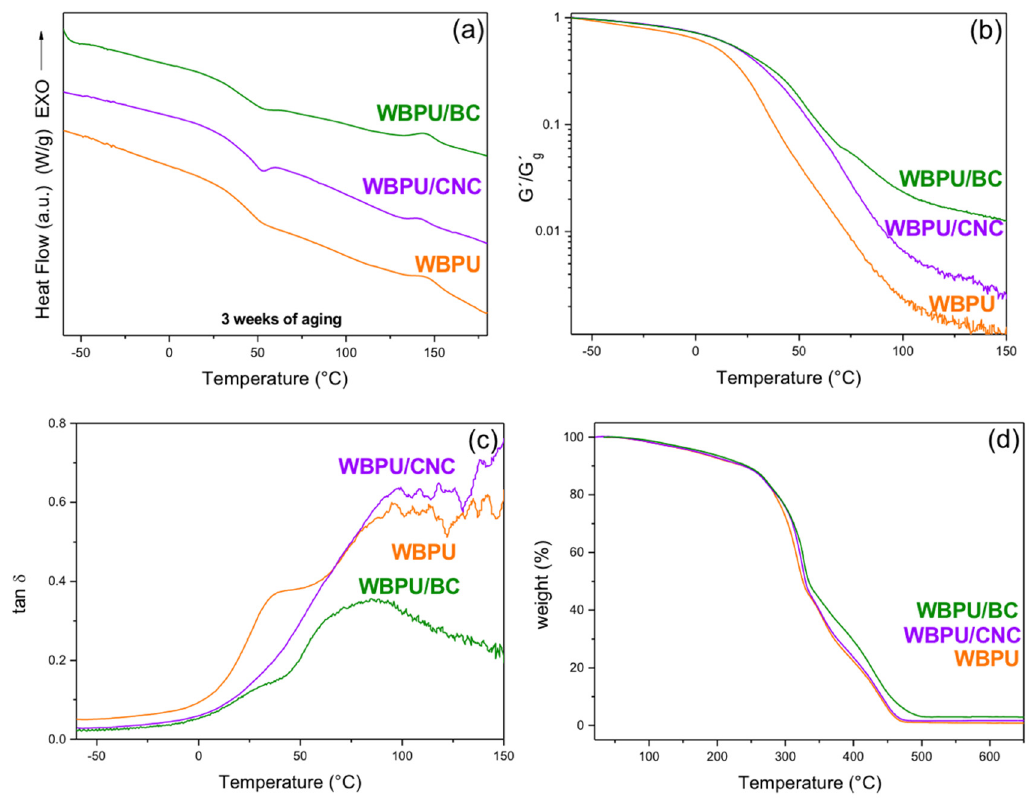
Figure 7. ( a ) Differential scanning calorimetry (DSC) traces with 3 weeks of aging; ( b ) normalized storage modulus; ( c ) tan δ of the films; ( d ) TG signal (residual weight %) of the films of the neat WBPU and the nanocomposites.